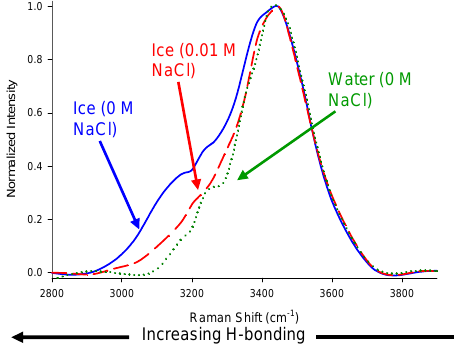
Fig. 1. Intensity-normalized glancing-angle Raman spectra of the surface of freshwater ice, of a frozen 0.01molL − 1 NaCl solution, and of the surface of liquid freshwater. The lower relative intensity at lower wavenumbers for the frozen salt solution and the liquid freshwater is indicative of reduced hydrogen bonding